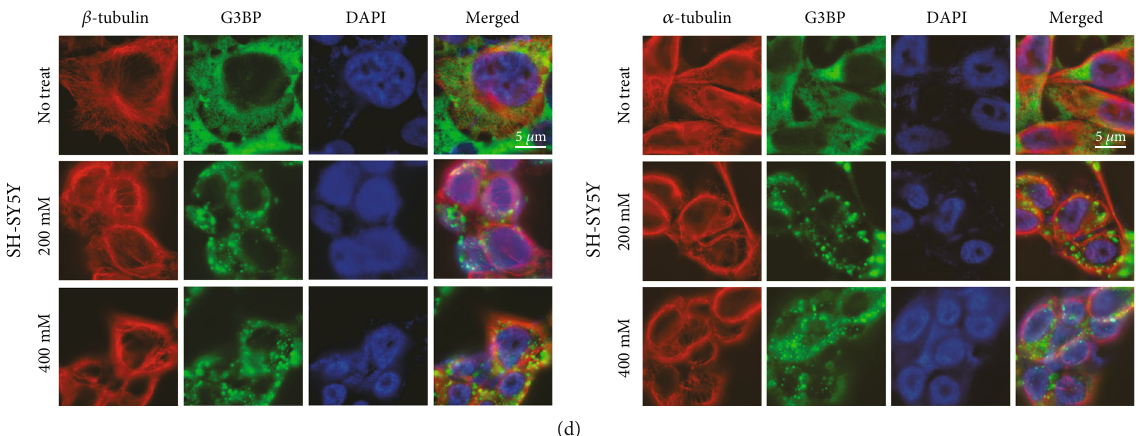
Figure 6: Downregulation of NaCl treatment alters tubulin expression and tubulin network of hiPSCs/IMR90-1. (a) Cells were treated with NaCl for 1h and then lysed with RIPA bu ff er. The lysates were separated with SDS-PAGE, transferred onto PVDF membranes, and probed with anti- α -tubulin, anti- β -tubulin, and anti- β -actin antibodies. A representative immunoblot analysis in IMR90/iPSCs and SH-Y5Y cells is shown. (b) Intensity of each band of the immunoblot was measured by the NIH ImageJ program, and the ratios of tubulin and β -actin in each treatment was calculated. (c, d) Representative fl uorescence microscopy images showing nontreated hiPSCs/IMR90-1 and SH-SY5Y, cells treated with 200 and 400mM of sodium chloride stained with the robust SG marker (G3BP (green)), β -tubulin (c) and α -tubulin (d) (red), the largest of the cytoskeletal polymers forming microtubules. Nucleus is stained in blue (Hoechst). Insets show magni fi ed views of SGs and microtubule fi laments. Scale bar indicates 5 μ m. ns: not signi fi cant compared to NT; ∗∗ p value less than 0.01 compared to